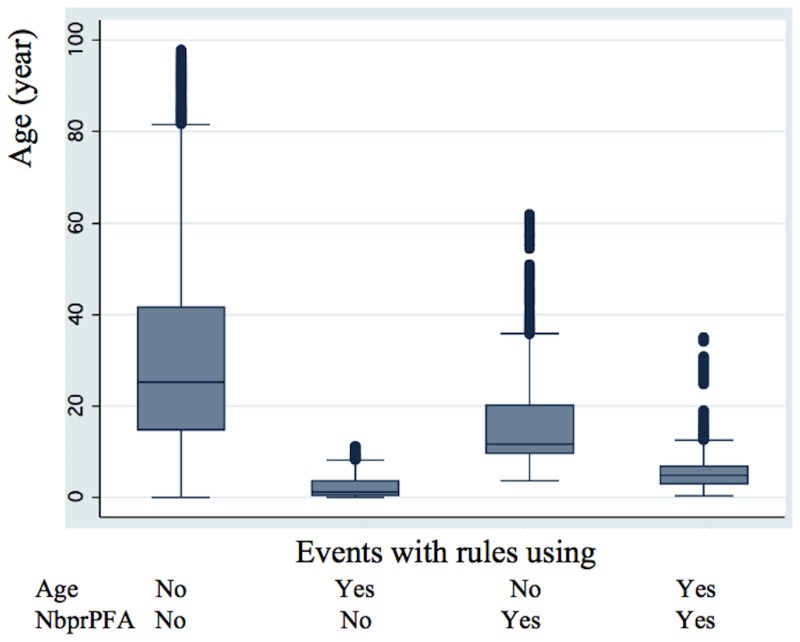
Age distribution of events present in rules using either “Age” or “Number of previous PFA”, both or neither in “DielmoAll” analysis.Events are divided into four groups depending on their presence/absence within the two rules, one using “Age” and the other “Number of previous PFA” variables. After verifying by a one-way ANOVA that the four groups have different mean ages (F (3,23770) = 3350.86; P<0.0001), the Scheffe test shows that each of the four groups has a mean age significantly different from the others (P<0.001).